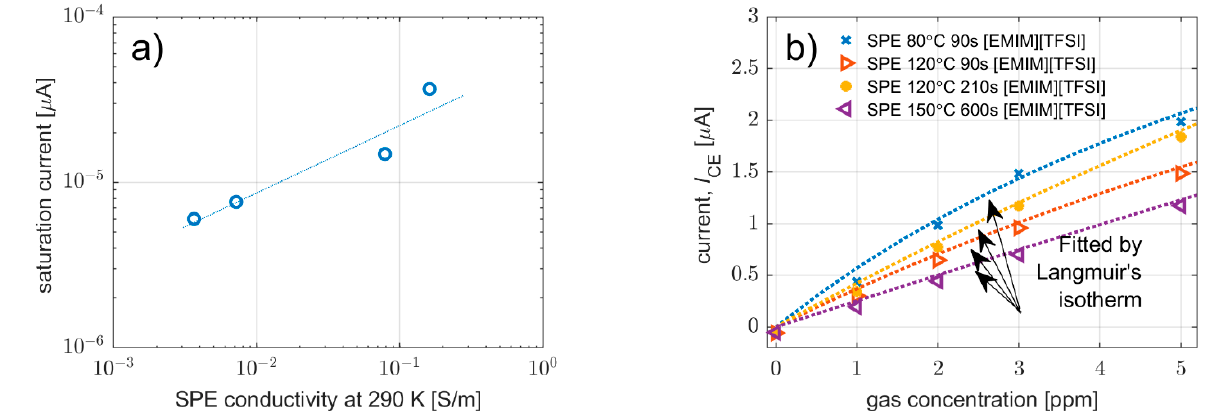
Figure 8. ( a ) Saturation current of sensor response as a function of SPE conductivity. ( b ) Current response as a function of NO 2 concentration for three sensors prepared with various crystallinities (i.e., of various conductivities). The measured points were fitted by a function derived from the Langmuir adsorption isotherm.